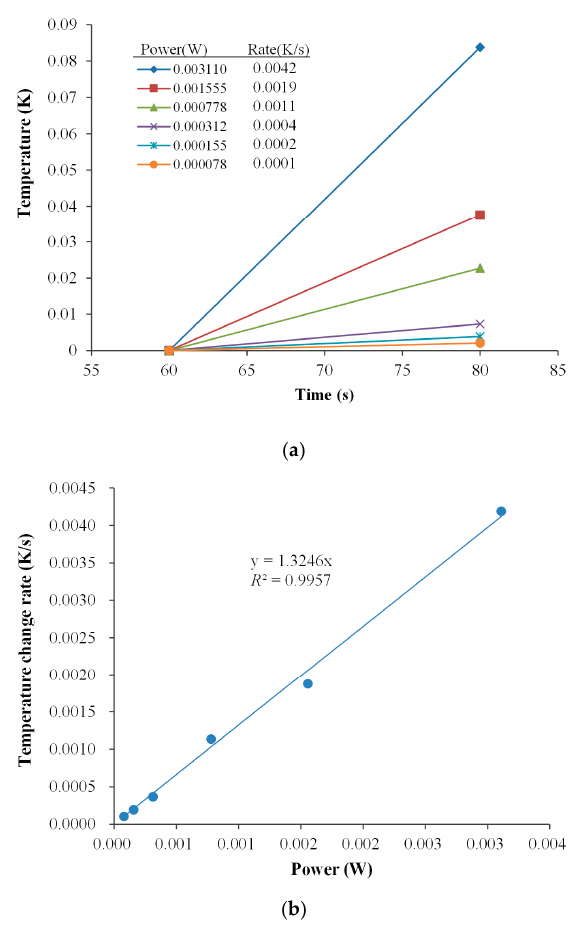
Figure 5. Electrical calibration of the proposed multichannel calorimetric simultaneous assay platform. ( a ) Temperature-time plot in the present of various Joule heating power of the proposed MCSA platform; ( b ) Regression curve between the temperature change rate and Joule heating power.